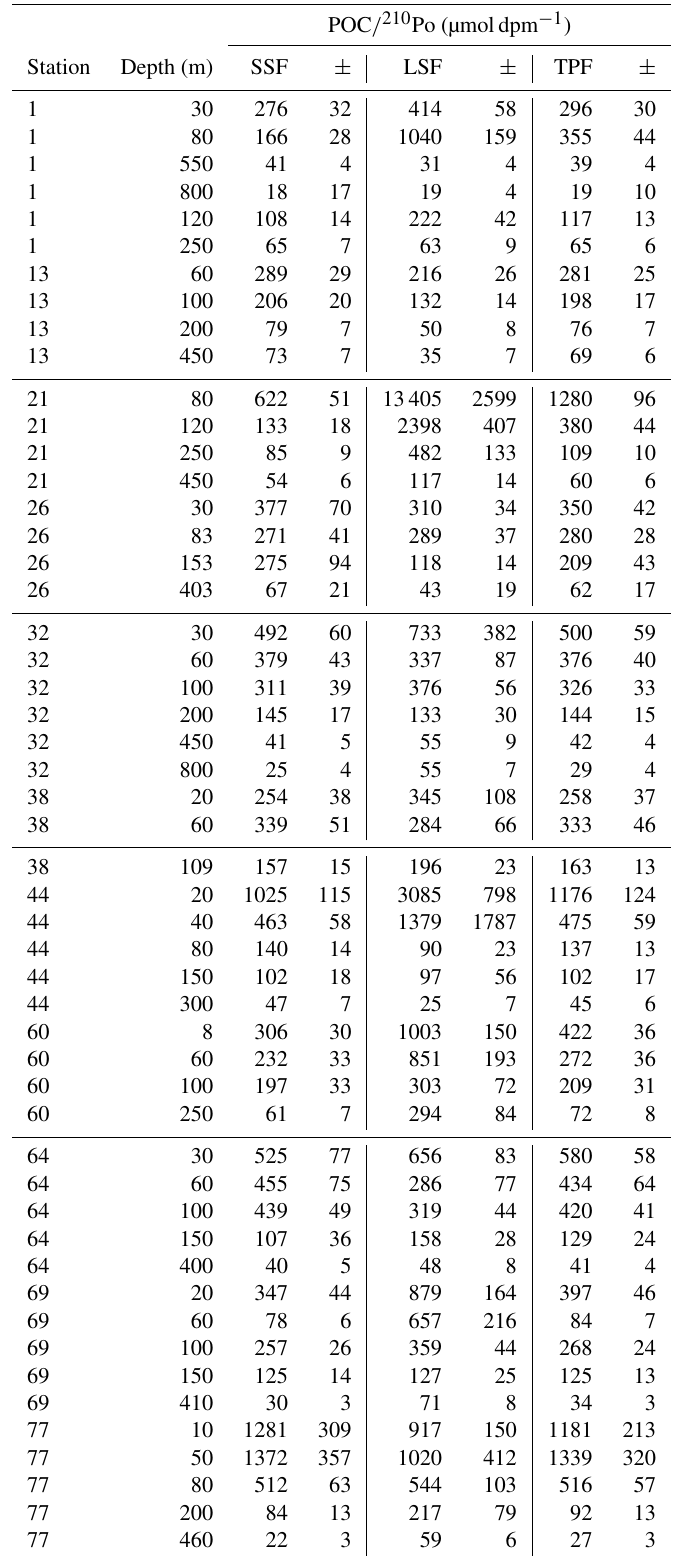
Table 3. The ratio of POC concentration to 210 Po activity (POC / 210 Po) in the particles collected by in situ pumps. SSF is small-size fraction (1–53µm); LSF is large-size fraction (>53µm); TPF is total particulate fraction